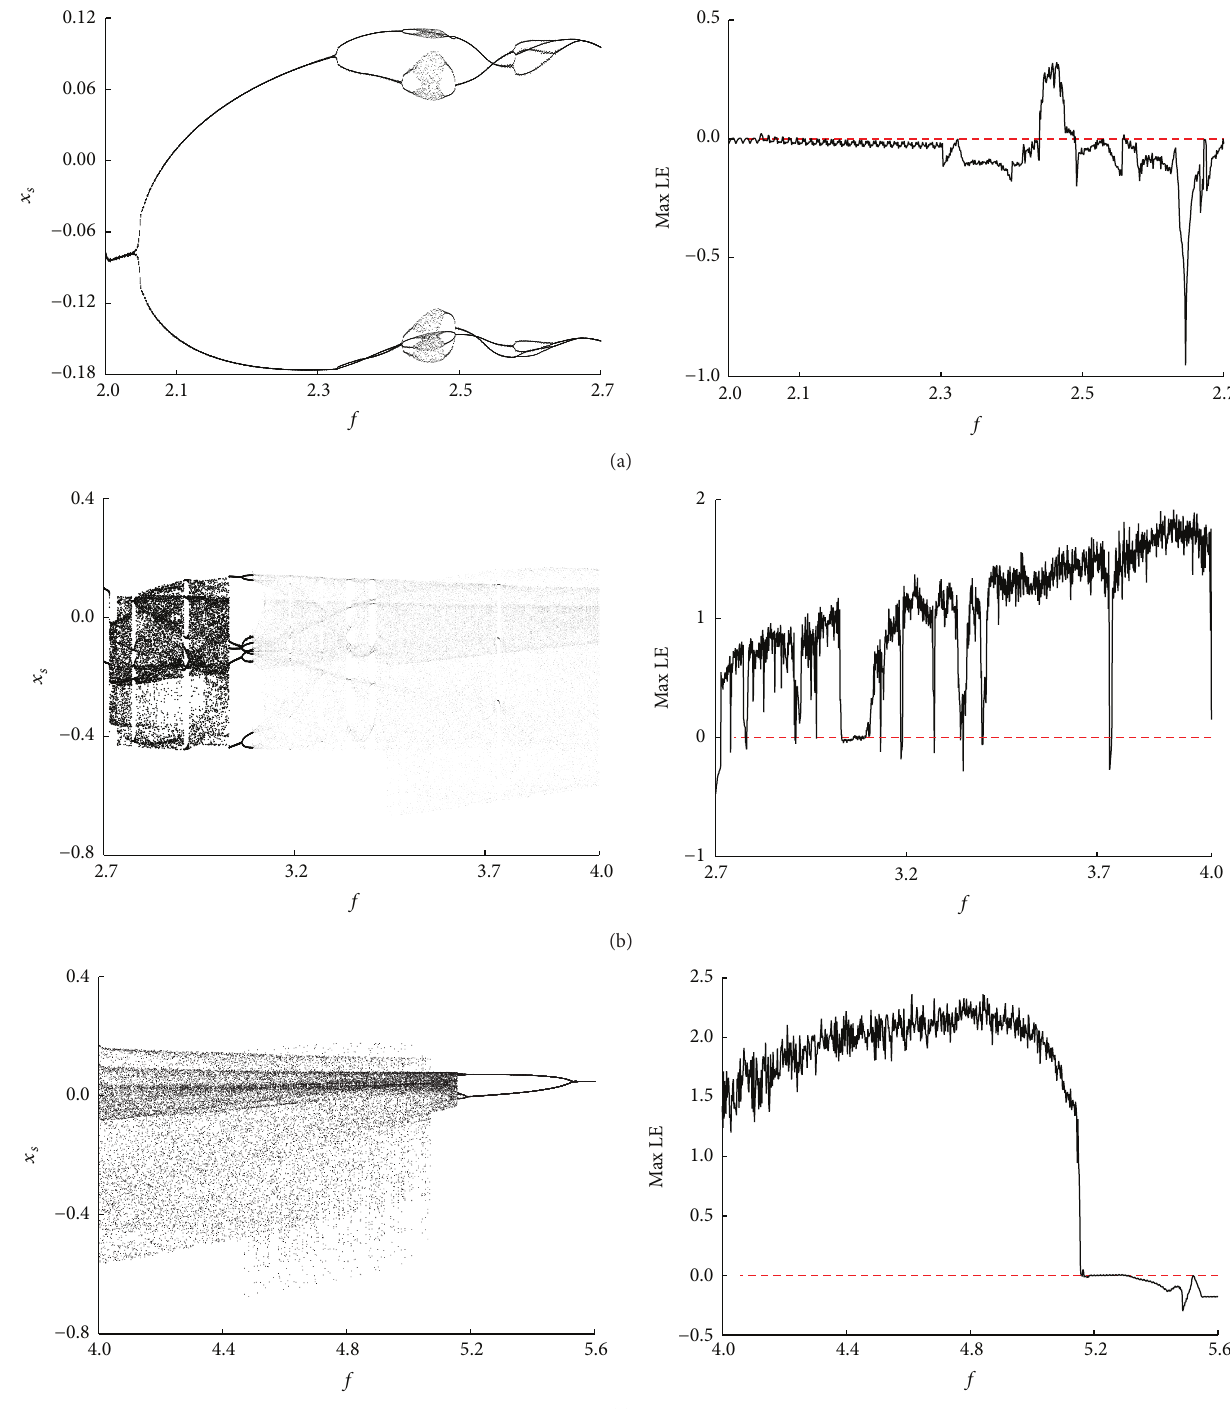
Figure 5: Bifurcation diagram and max LEs diagram of 𝑥 𝑠 by varying 𝑓 : (a) 𝑓 ∈ ( 2.0–2.7) Hz; (b) 𝑓 ∈ ( 2.7–4.0) Hz; (c) 𝑓 ∈ ( 4.0–5.6) Hz.